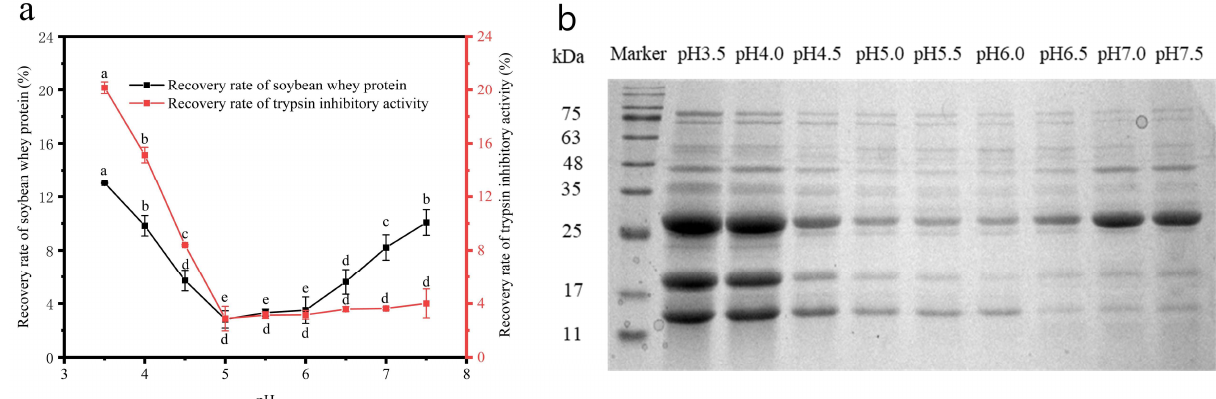
Figure 2. The effect of pH on STI isolation and purification ( a ). The electrophoretic pattern of the protein isolated from the soybean whey by pH precipitation ( b ). Different letters on the same series indicate significant differences ( p < 0.05) in varying conditions.